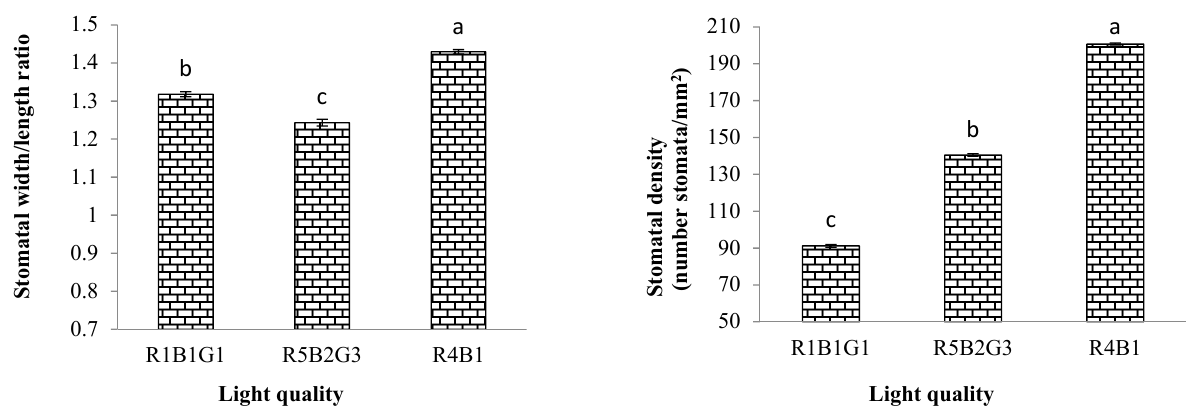
Figure 4. Characteristics of the stomatal cells in the adaxial spinach epidermis leaves for the different light qualities. The error bars show the standard errors. Data were analyzed by R software. Different letters indicate a significant difference among treatments ( p ≤ 0.05).